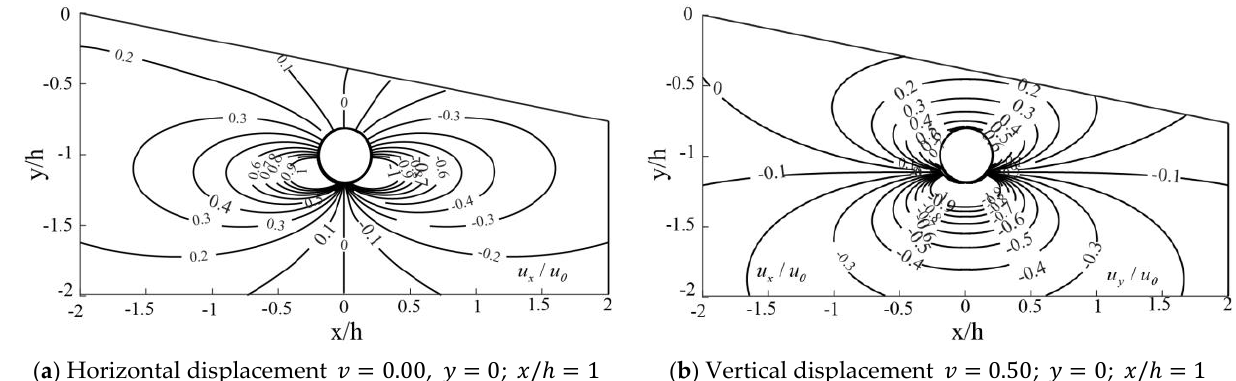
Figure 6. Stratigraphic displacement of the tunnel wall (uniform convergence).